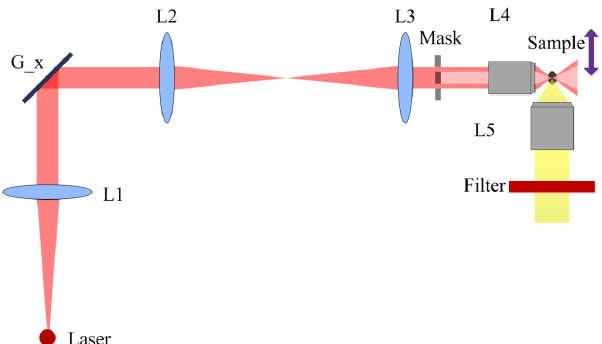
Fig. 13. Conjugation of imaging system. L1, L2, L3 are the lenses; L4 is the illumination lens; L5 is the detection lens. The shape of D-aperture mask is shown in Fig. 1.